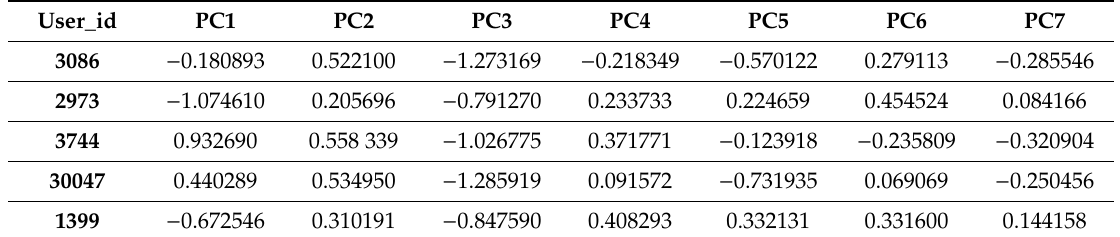
Table A3. Individual positioning of users on principal